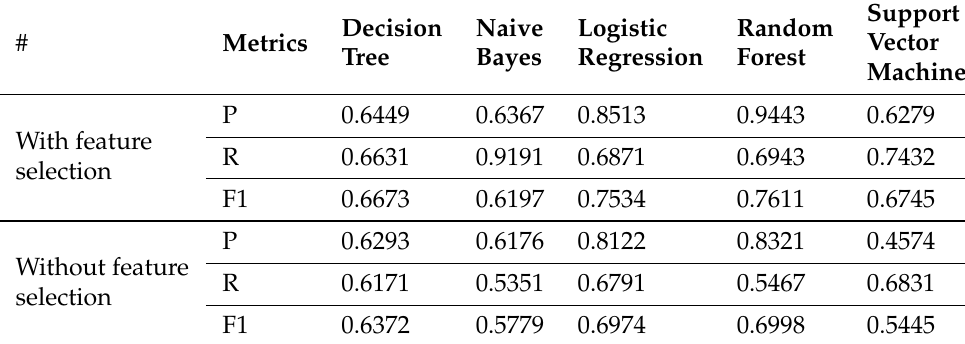
Table 8. Records with and without feature selection.